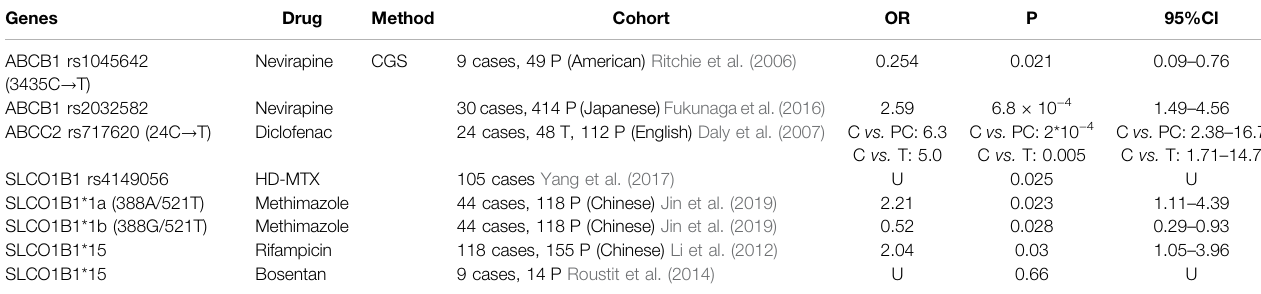
TABLE 3 | Polymorphisms of DILI-related transporter genes identi fi ed in GWAS and CGS. Genes Drug